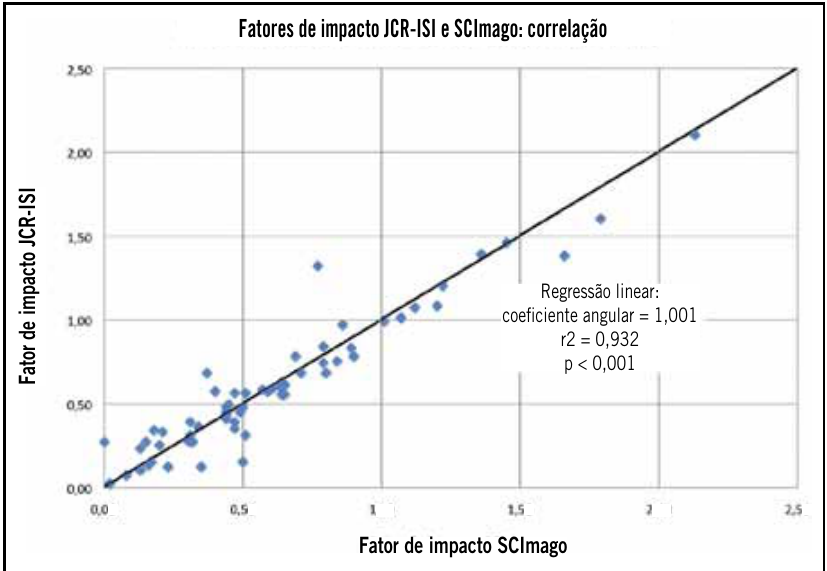
Fatores de impacto JCR-ISI e SCImago: correlação